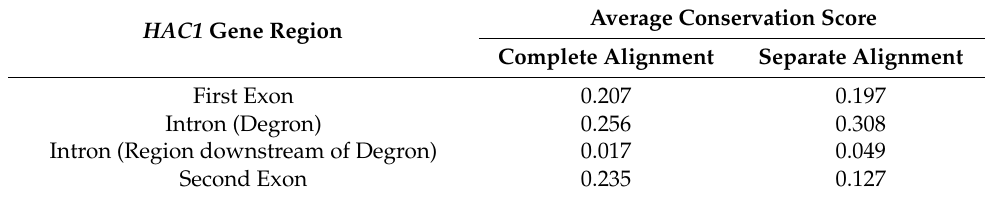
Table 3. The averaged nucleotide site conservation at HAC1 exons and introns (at Degrons and downstream sequences) as scored by PhastCons. The conservation scores at “Complete Alignment” were computed using entire HAC1 gene alignments, whereas scores at “Separate alignment” were computed using HAC1 CDS and intron sequence alignments separately.